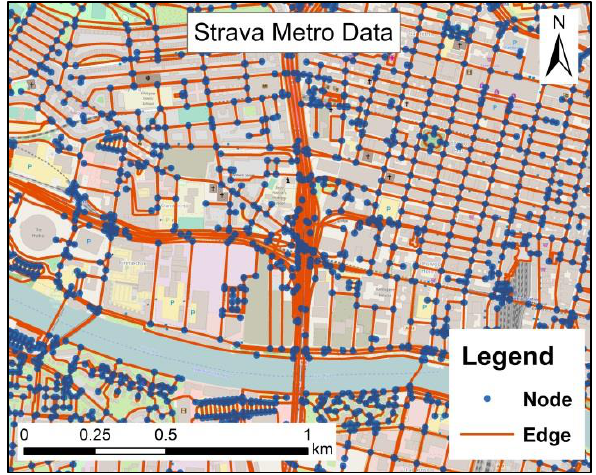
Figure 1. Nodes and edges of Strava Metro data (Basemap: